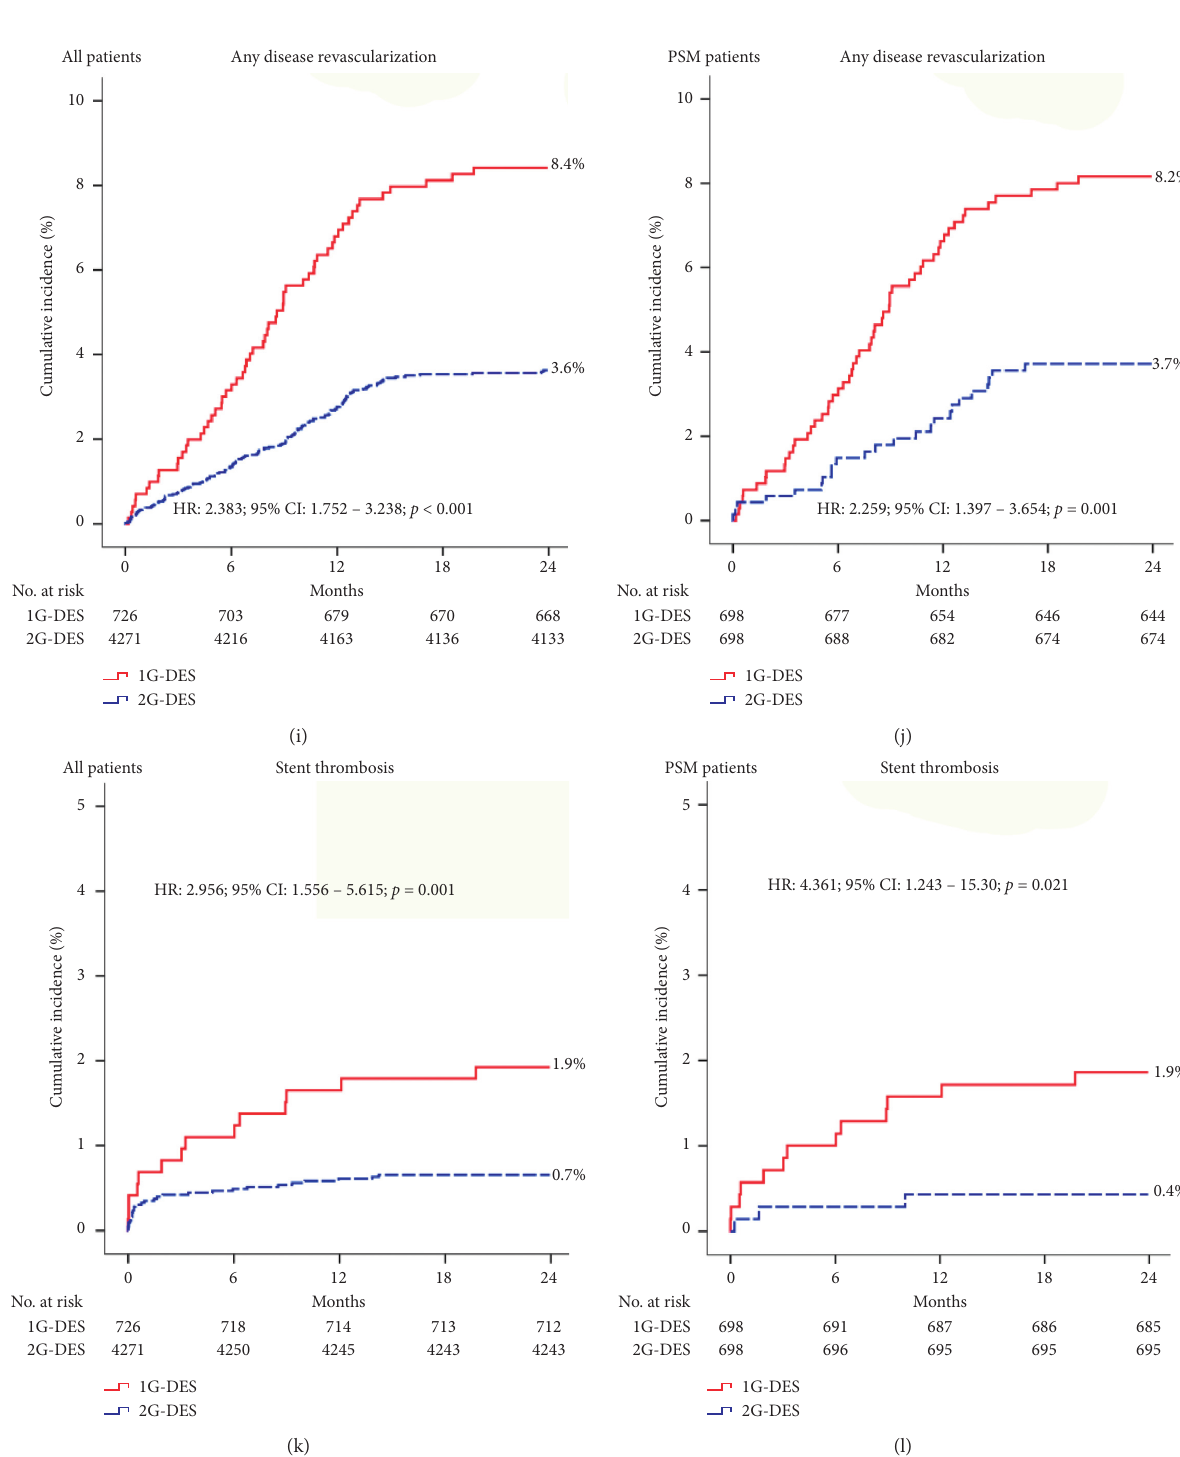
Figure 2: Kaplan–Meier analysis of the incidence rates of POCOs (a, b), all-cause death (c, d), cardiac death (e, f), Re-MI (g, h), any disease revascularization (i, j), and ST (k, l) in all patients (a, c, e, g, i, k) and PSM patients (b, d, f, h, j, l) at 2 years. 1G: first-generation; 2G: second- generation; DES: drug-eluting stent; HR: hazard ratio; CI: confidence interval; POCOs: patient-oriented composite outcomes; Re-MI: recurrent myocardial infarction; ST: stent thrombosis; PSM: propensity score-matching